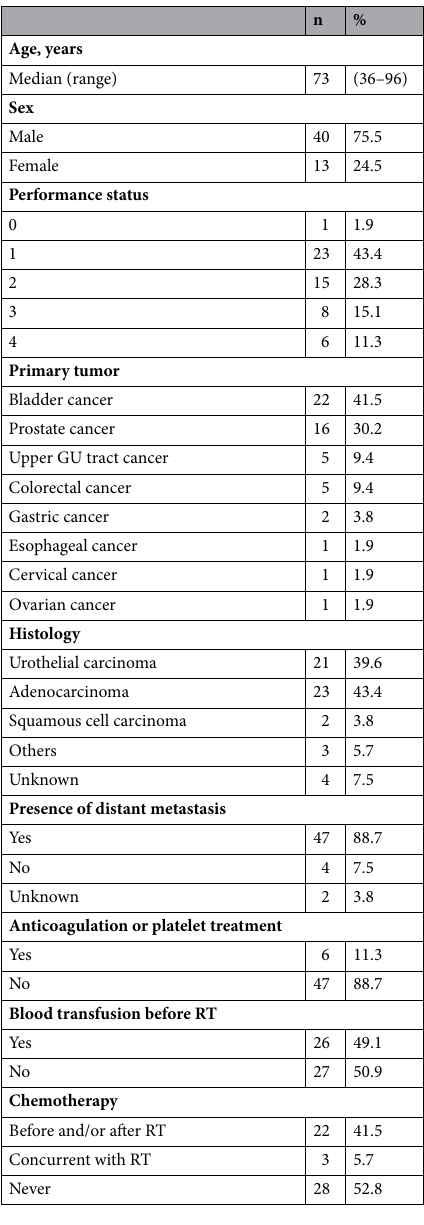
Table 1. Patient characteristics at baseline. Abbreviations: RT radiation